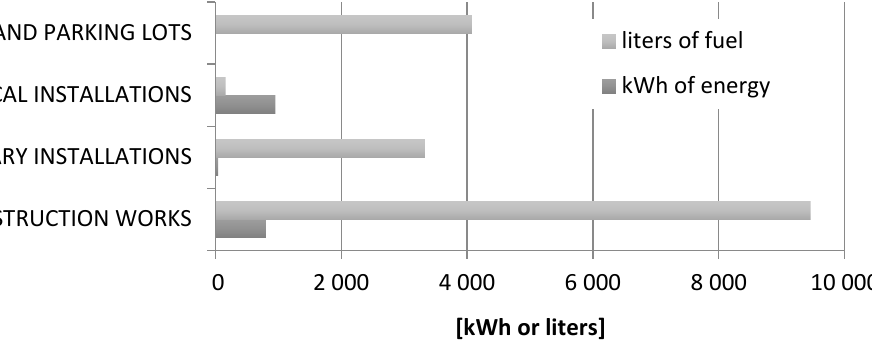
Figure 6. Energy (kWh) and fuel (liters) consumed by the equipment used in the construction of the research object [own study based on the investor’s data].